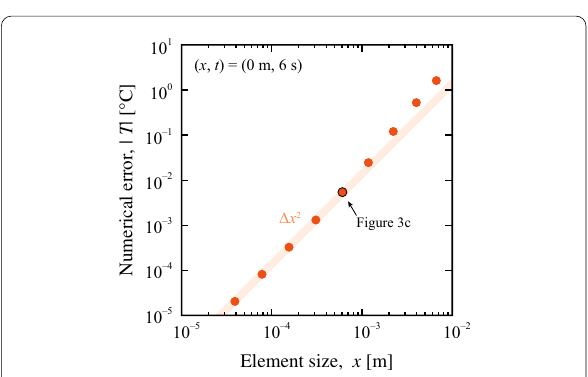
Fig. 4 Convergence test for numerically solving Eq. (12). The (cid:31) T ( 0 m,6 s ) and plotted numerical error was evaluated at ( x , t ) | | = against element size (cid:31) x . The numerical solutions were obtained by the explicit Runge–Kutta method of order 5(4) (see main text for details). All parameters, except for (cid:31) x , are the same as those used